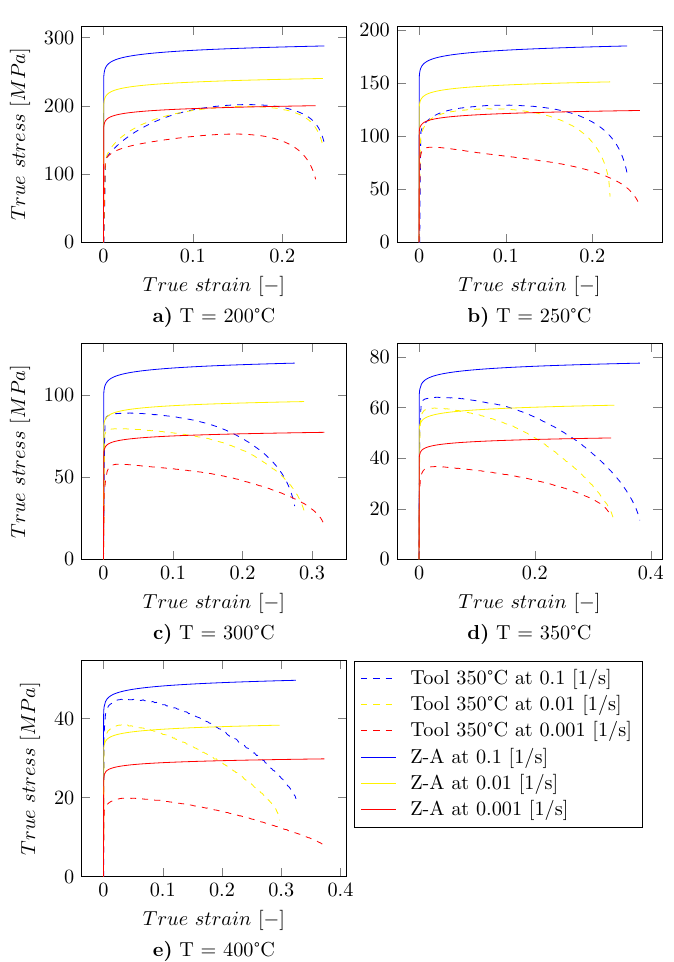
Figure 7. Experimental data and Z–A modeling results depicting stress–strain curves of AA7075 sam- ples formed in the tool with a temperature of 350 ◦ C for testing temperatures of ( a ) 200 ◦ C, ( b ) 250 ◦ C, ( c ) 300 ◦ C, ( d ) 350 ◦ C and ( e ) 400 ◦ C; Experimental data are shown by dashed lines, whereas, predicted data are highlighted by solid lines.